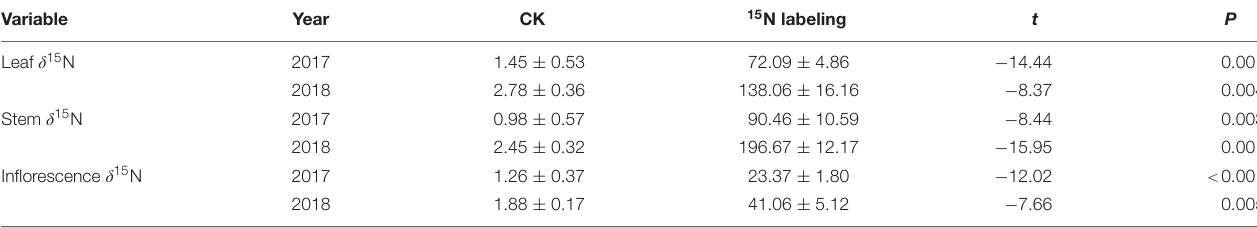
TABLE 2 | Comparison of the δ 15 N of reproductive ramets in Leymus chinensis between the control and 15 N labeling treatments (means ± SE, n = 4). Variable